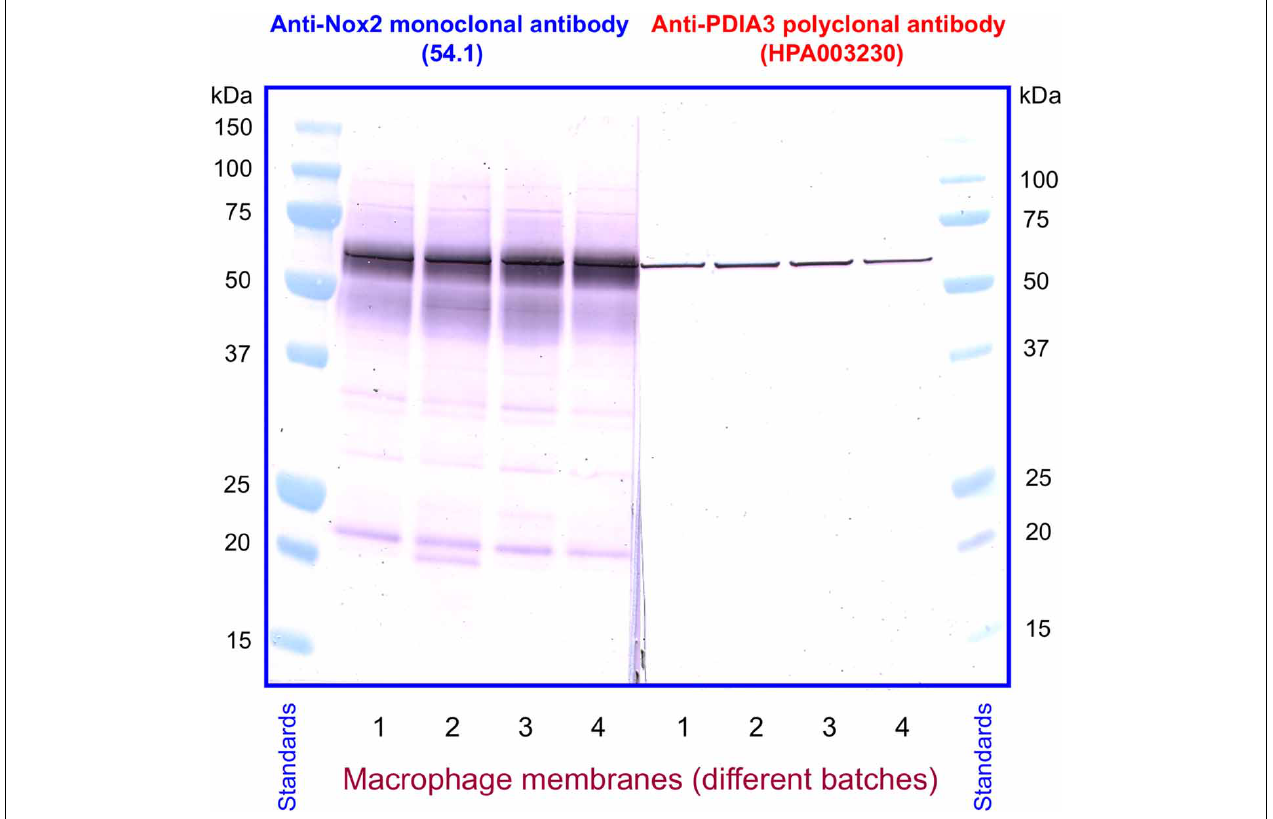
FIGURE 11 | Detection of PDIA3 in macrophage membranes by both anti-Nox2 and anti-PDIA3 antibodies. Monoclonal anti-Nox2 antibody 54.1, which recognizes recombinant PDIA3 (see Figure 9A ), is shown to detect in macrophage membranes an antigen most likely to be PDIA3. This appears in four distinct membrane batches as a sharply defined band on the background of the more diffuse Nox2; the overlap